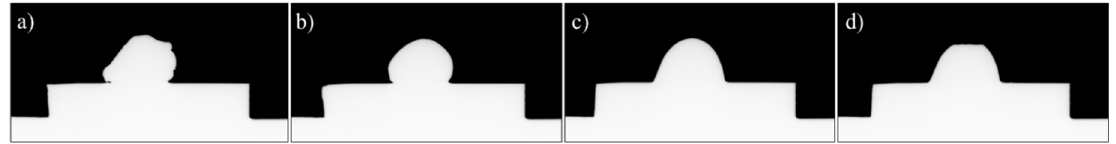
Figure 6. Drop profiles of Fe50_SPS in contact with pure Sn at ( a ) 0 s, ( b ) 100 s, ( c ) 600 s, and ( d ) 1200 s from melting.